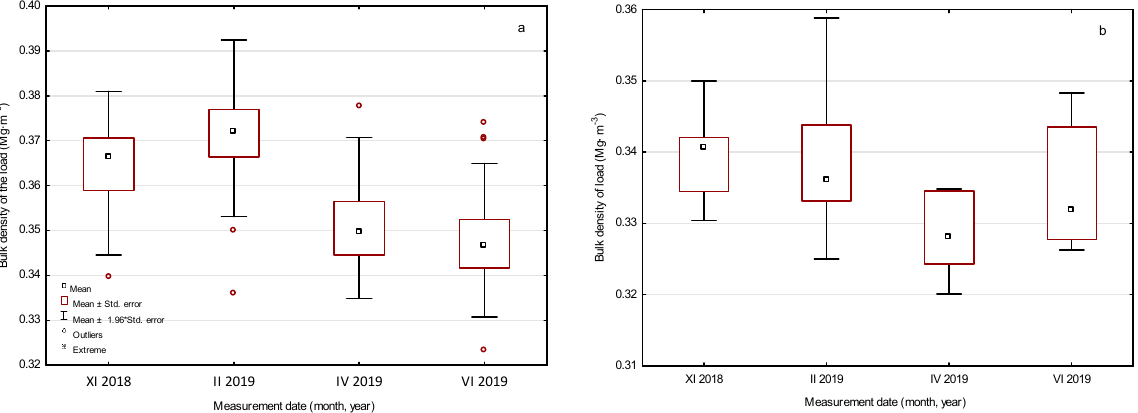
Figure 9. Comparison weight of load values by measurement date for unit A wood chips ( a ); sawdust ( b ).